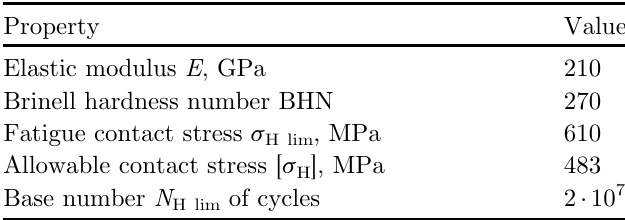
Table 6. Gear steel mechanical properties.